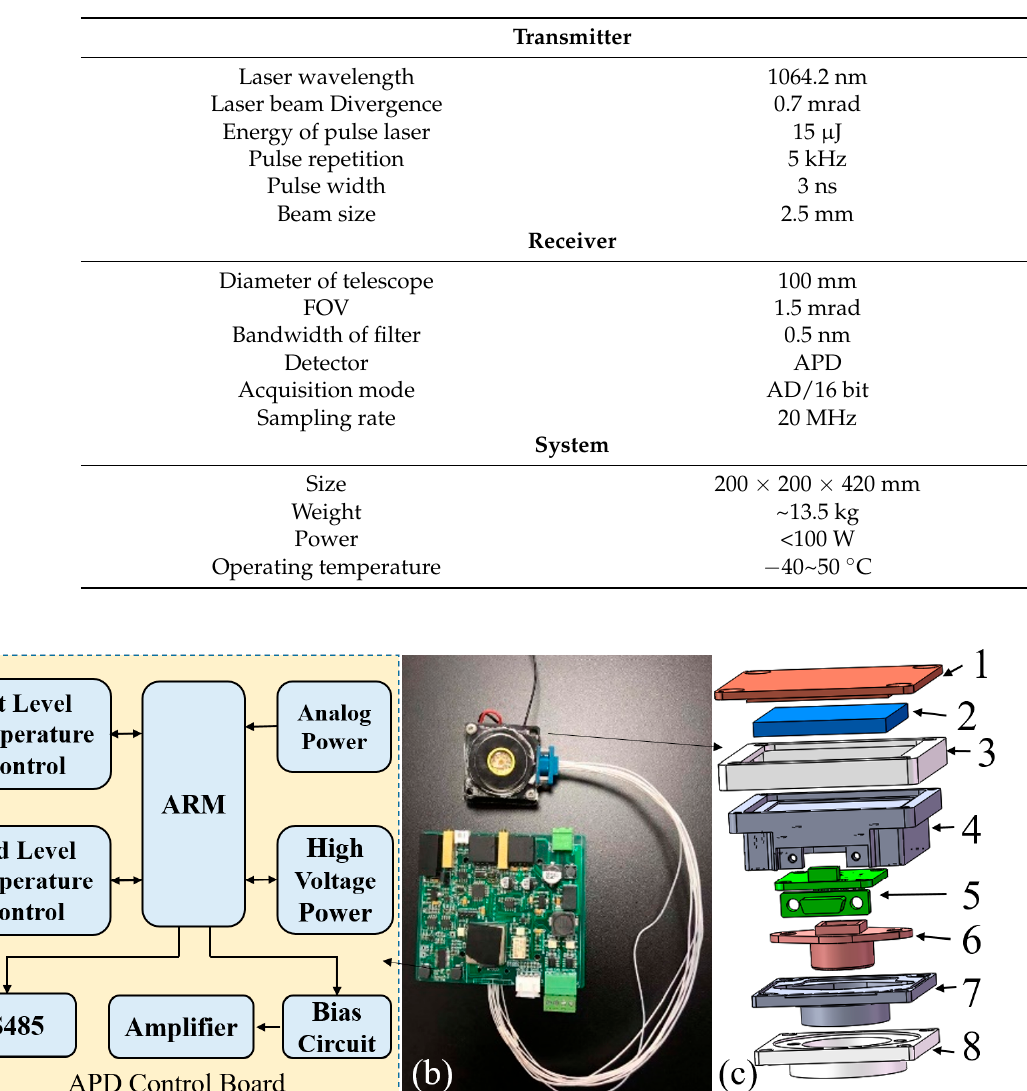
Table 3. Main parameters of mIRLidar.